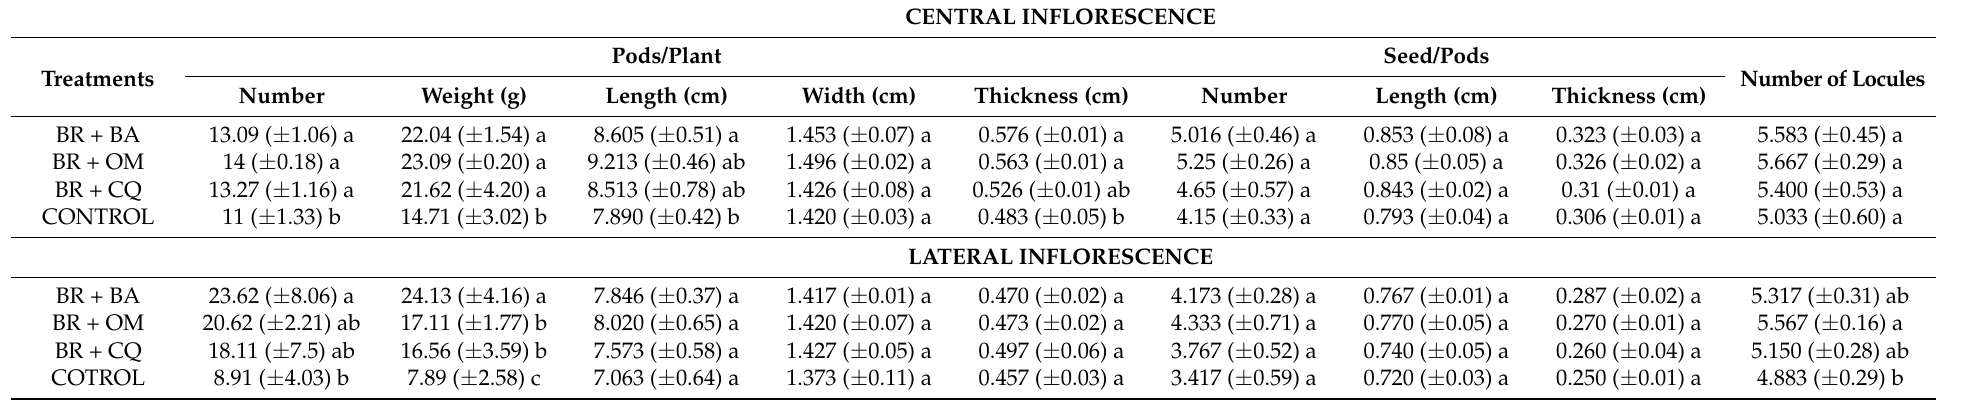
Table 9. Effect of treatments on the pods and seeds of the central and lateral